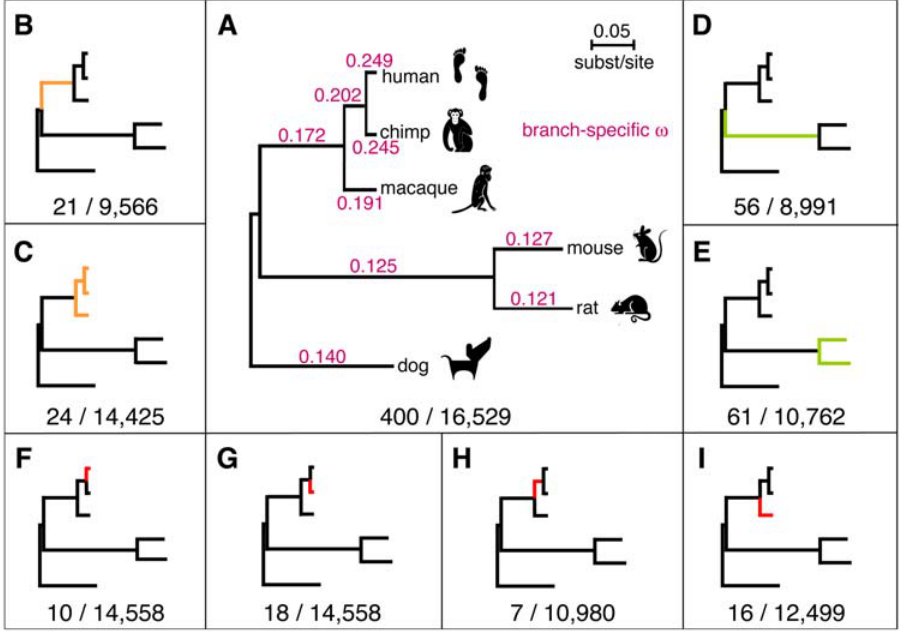
Figure 1. The LRTs used to detect positive selection in the six mammalian genomes. (A–I) Panel A shows the test for selection on any branch of the phylogeny, and panels B–I show the lineage- and clade-specific tests, with branches under positive selection highlighted. The numbers below each subfigure represent the number of positively selected genes identified by each LRT (FDR , 0.05) and the total number of ortholog sets tested. In (A), branch lengths are drawn proportional to their estimates in substitutions per site, and each branch is labeled with the corresponding estimate of v . All tests are based on an unrooted phylogeny; the trees are rooted for display purposes only. Nominal P -value thresholds for FDR , 0.05 were: (A) 1.1 6 10 2 3 , (B) 9.1 6 10 2 5 , (C) 7.7 6 10 2 5 , (D) 2.9 6 10 2 4 , (E) 2.8 6 10 2 4 , (F) 2.5 6 10 2 5 , (G) 5.4 6 10 2 5 , (H) 1.8 6 10 2 5 , (I) 5.9 6 10 2 5